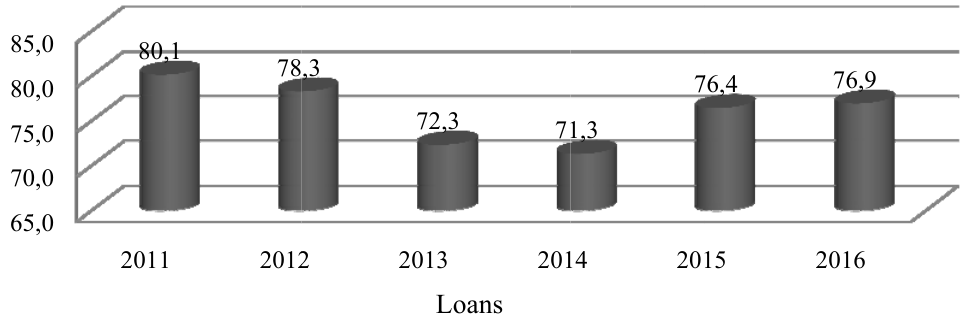
Fig. 2. D Dynamics of the piled by the aut